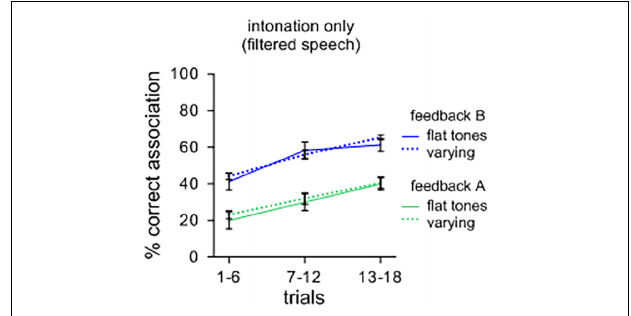
FIGURE 2 | Percent correct sound-picture association for different sets of filtered lexemes. Items with varying (rising and falling) tones did not lead to more symbolic associations than items with only flat tones.